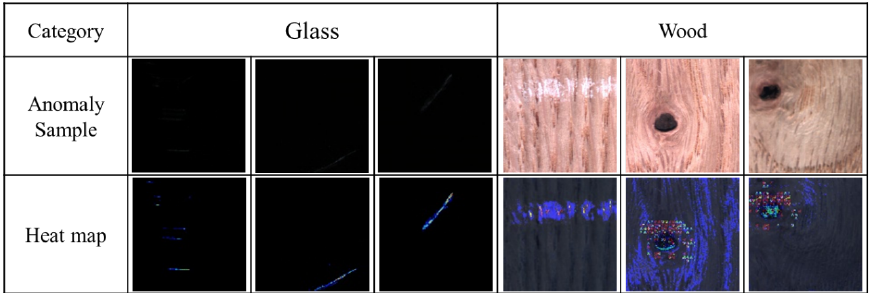
Figure 9. Heat maps of the glass and wood datasets generated by the proposed method (DAGAN).